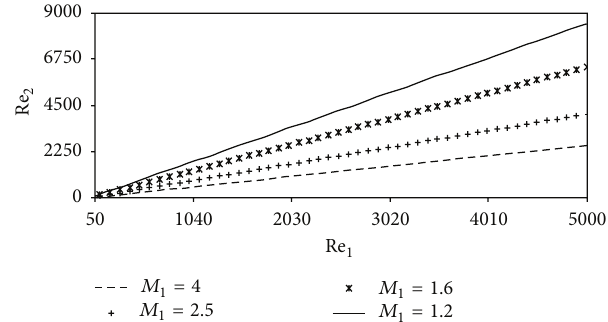
Table 2: Representation of pressures ratio ( 𝑝 2 /𝑝 1 ) with respect to